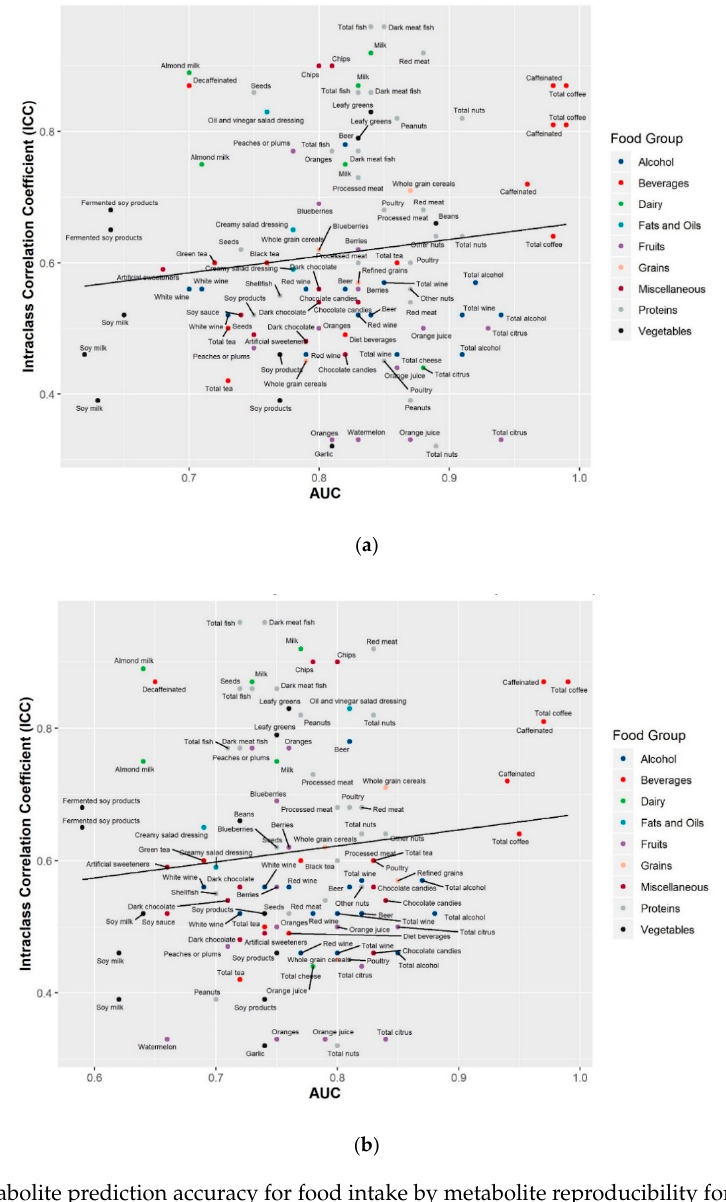
Figure 1. Metabolite prediction accuracy for food intake by metabolite reproducibility for the top three predictive metabolites of 74 food groups / items in the Cancer Prevention Study-3 Diet Assessment Sub-study. ( a ) Top three predictive metabolites for food intake assessed using the food frequency questionnaire; ( b ) top three predictive metabolites for food intake assessed using the average of 24-h diet recalls. Prediction accuracy was assessed by area under the curve (AUC) from the receiver operating characteristic curve, which indicates how well a metabolite could discriminate top quartile from bottom quartile intake of a food group / item. Reproducibility was assessed by intraclass correlation coe ffi cients (ICCs), calculated as the ratio of between-person variance to the total variance among participants with repeated blood metabolic profiles measured six months